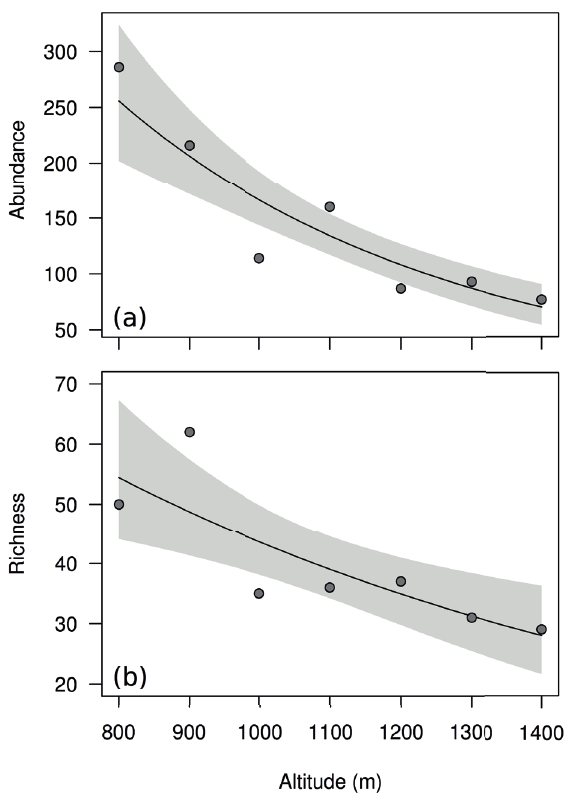
Figure 2. Effect of altitude on (a) butterfl y abundance and (b) richness in Serra do Cipó, Brazil. The solid lines represent the fi tted model, the shaded areas the confi dence intervals and the circles the observed